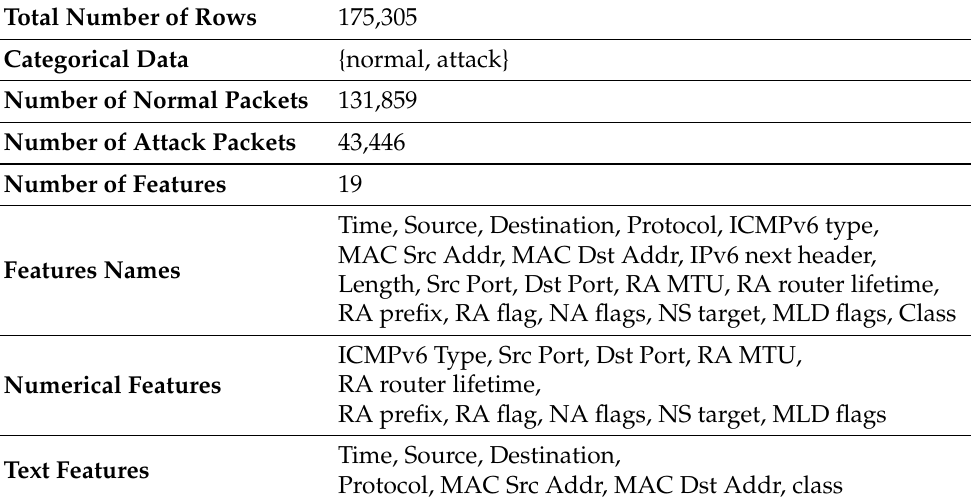
Table 2. Description of the